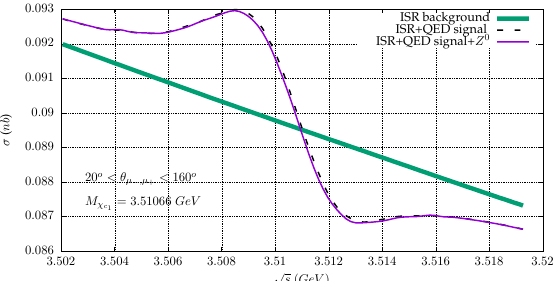
µ + µ − γ in the χ 2 - region. →